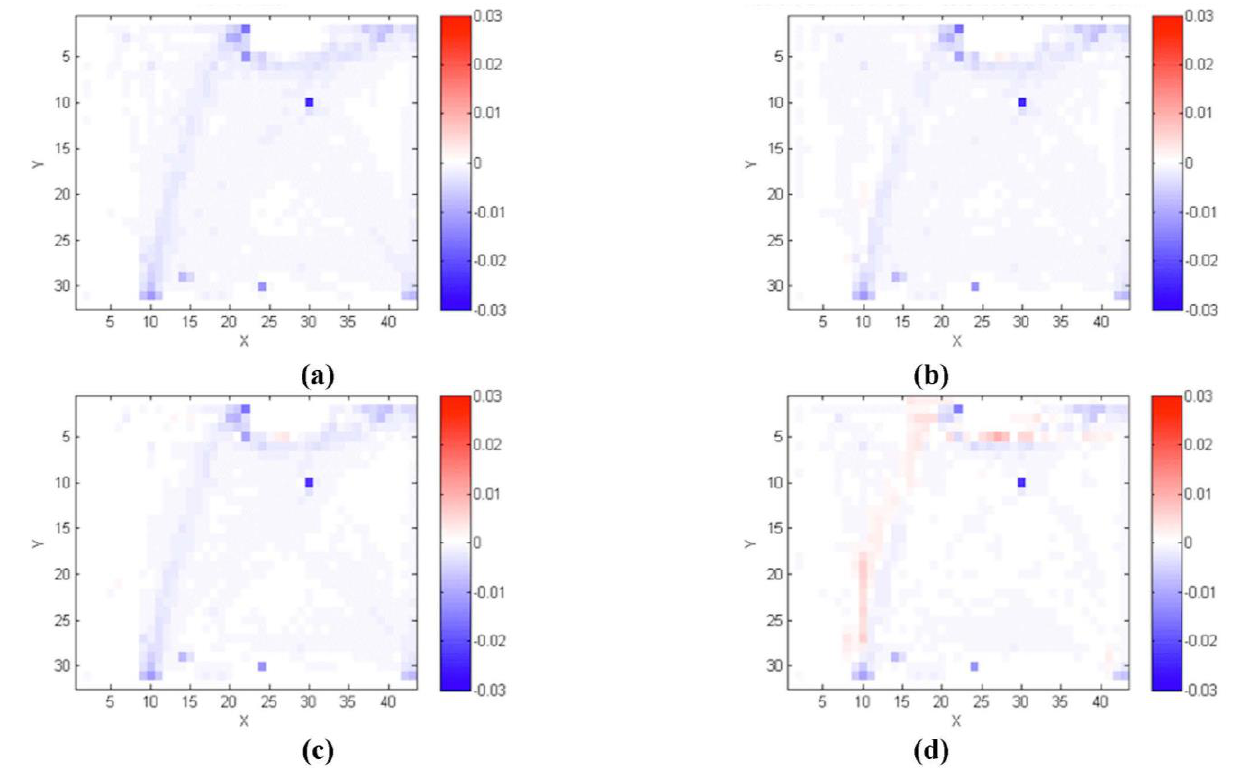
Figure 8. Normalized heat maps comparing a specific simulation scenario with the actual data. ( a ) Scenario 1: No realistic information about entrances, exits, or heat maps; ( b ) Scenario 2: realistic entrance/exit probabilities but disabled heat maps; ( c ) Scenario 3: realistic heat maps but disabled entrance/exit probabilities; ( d ) Scenario 4: realistic entrance/exit probabilities and heat maps